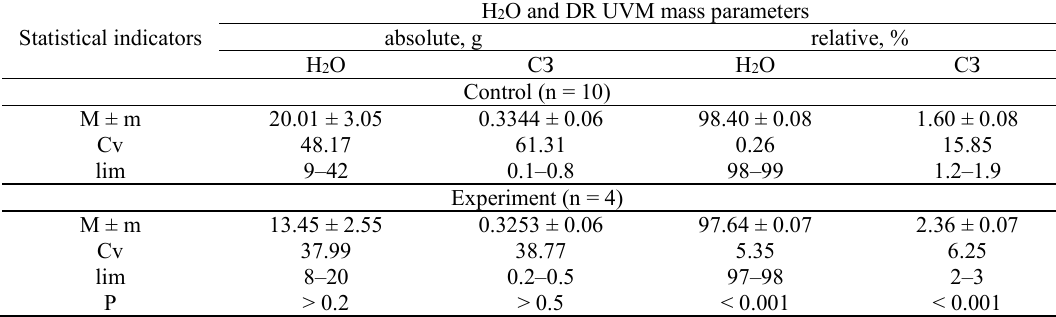
Parameters of mass of components of uterine and vaginal mucus Statistical